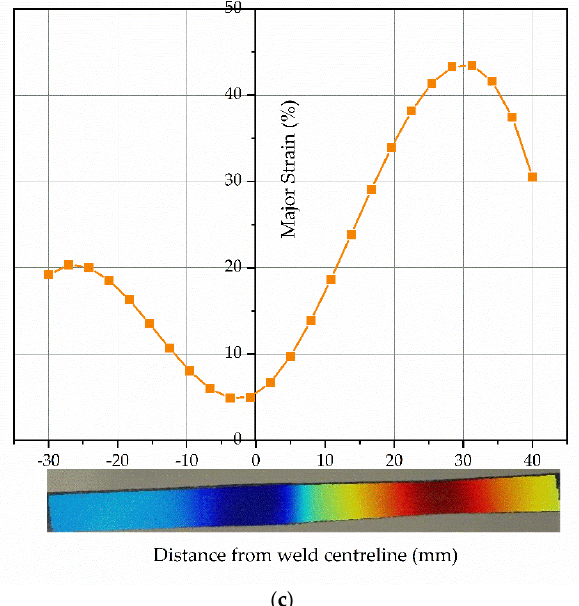
Figure 10. Strain distribution prior to fracture during DIC analysis: ( a ) UT specimen; ( b ) HT specimen; ( c ) CT specimen. Variation of major strain for UT, HT, and CT specimens at different stages are ob- tained from the DIC results and plotted in Figure 11. In all cases, strain has increased linearly up to certain stage (yield point) after that it decreased slightly and again increased up to necking. This suggests that the elastic deformation, as well as plastic deformation, have occurred in the specimens. Strain is more pronounced in SS 316L HAZ for all speci- mens. Maximum local strain values for UT, HT, and CT during necking were found to be 29.5, 35.96, and 44.31%, respectively. CT specimen has 18.84 and 33.42% higher strain val- ues when compared to HT and UT specimens. It can be concluded that, the ductility of the weld joint has been improved by the cryogenic treatment which has resulted in larger strain values in all the zones.